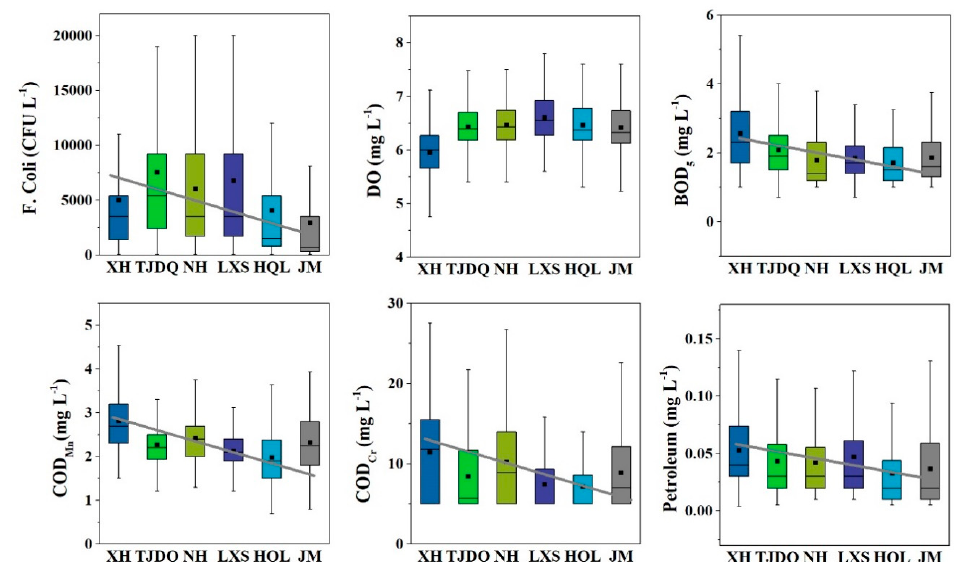
Figure 4. Concentration of F. Coli and physiochemical parameters (DO, BOD 5 , COD Cr , COD Mn and petroleum) from six sites in Nansha, Guangzhou, from 2008 to 2017. The sampling sites are ranked according to their distance from the city center: XH < TJDQ < NH < LXS < HQL < JM. The boxes represent the 25th and 75th percentiles, and the whiskers represent the minimum and the maximum. The horizontal bars within boxes represent median. The black points inside boxes represent mean. All outliers are not shown.